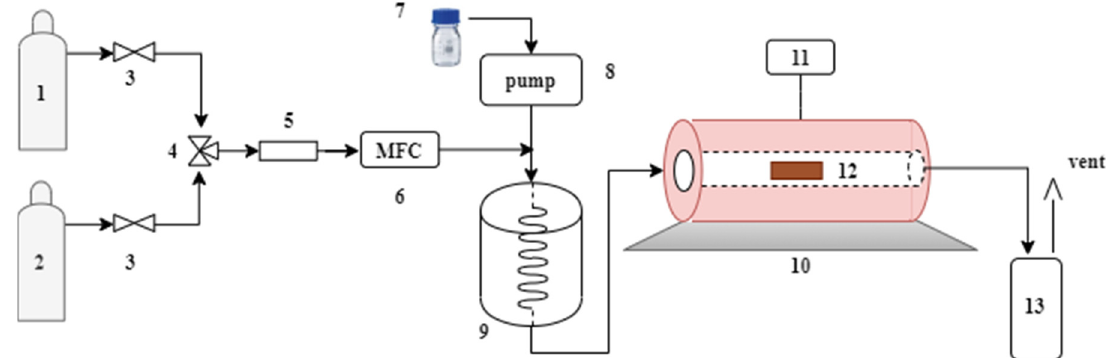
Figure 2. Schematic diagram of the experimental setup. ( 1 ) N 2 . ( 2 ) CO 2 . ( 3 ) On-off valve. ( 4 ) 3-way valve. ( 5 ) Filter. ( 6 ) Mass flow controller. ( 7 ) Water. ( 8 ) Peristaltic pump. ( 9 ) Steam generator. ( 10 ) Oven. ( 11 ) Temperature controller. ( 12 ) Sample. ( 13 ) Condenser.